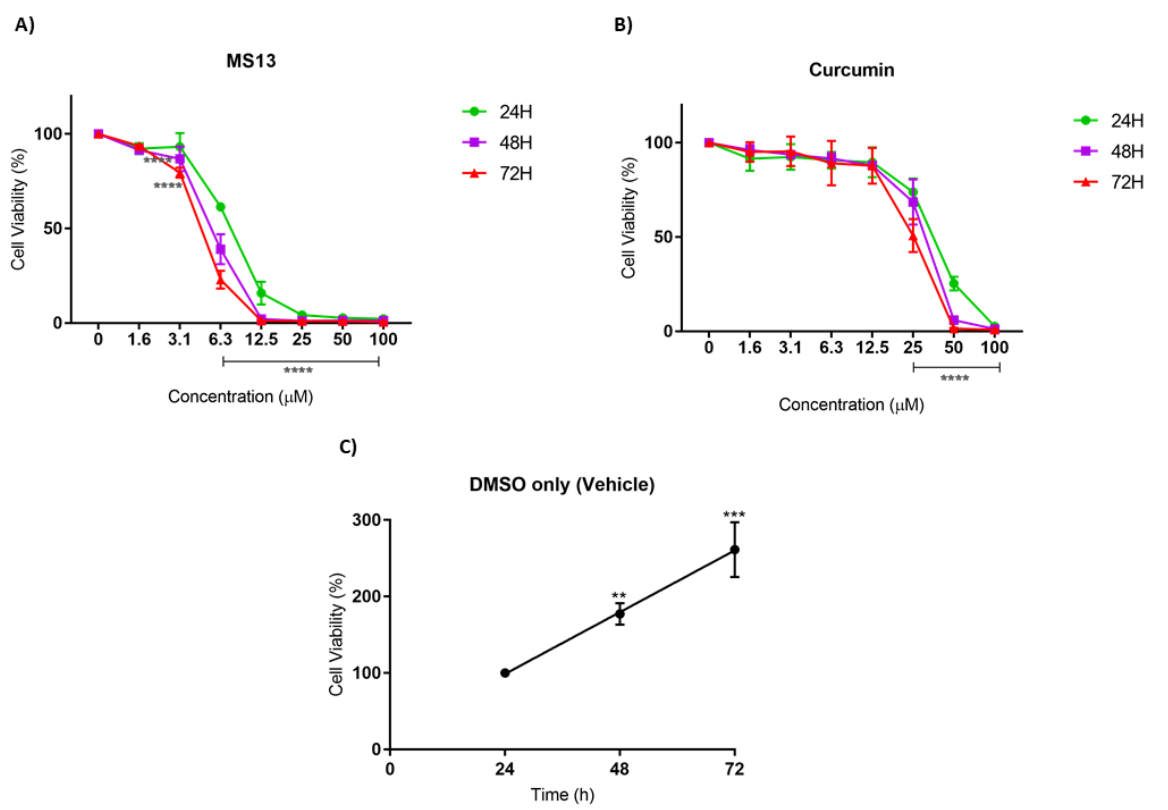
Figure 2. The antiproliferative effects of ( A ) MS13 and ( B ) curcumin on NCI-H520 cell line at 24, 48, and 72 h. The experiments were performed in triplicate and results were compared between three independent experiments. Results are presented as means of percentage of cell viability and comparison between data sets were statistically analyzed using ANOVA. Vehicle-treated controls of DMSO ( C ) were included to assess cell growth in untreated NCI-H520 cells over time. Asterisks indicate statistically significant differences between the means of the values obtained with treated versus untreated cells (** p < 0.01, *** p < 0.001 and **** p < 0.0001).